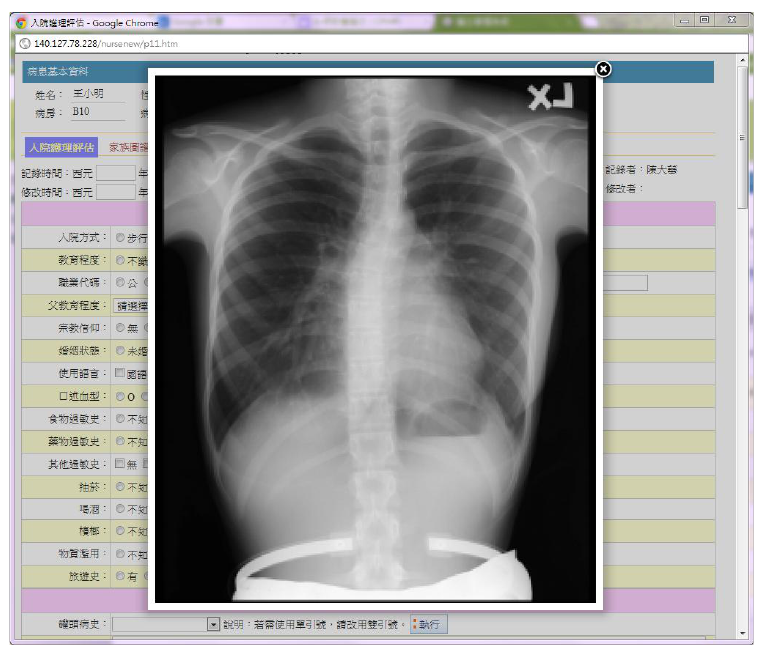
Figure 5. Medical image browsing service.